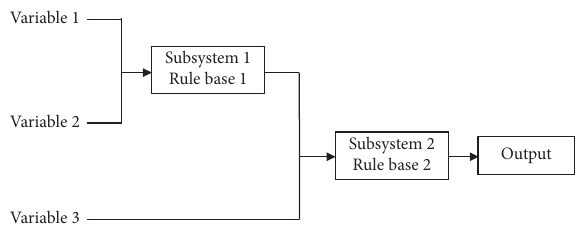
Figure 5: A simple structure of